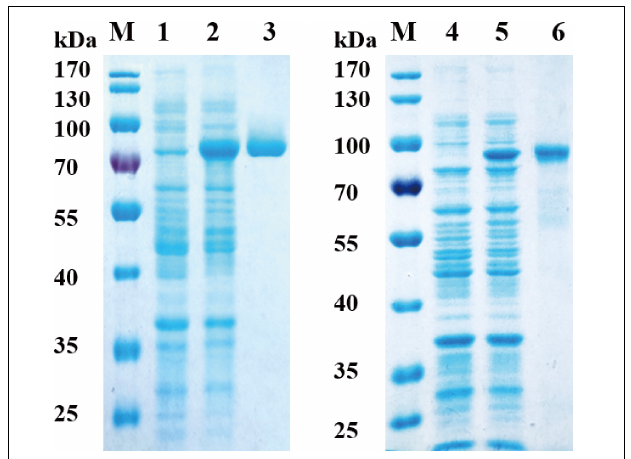
FIGURE 2 | Analysis of recombinant Bo3128 and Bo4416 by SDS-PAGE. M: molecular weight standards. (1) Culture lysate of Bo3128 before IPTG induction. (2) Culture lysate of Bo3128 after IPTG induction. (3) Purified Bo3128. (4) Culture lysate of Bo4416 before IPTG induction. (5) Culture lysate of Bo4416 after IPTG induction. (6) Purified